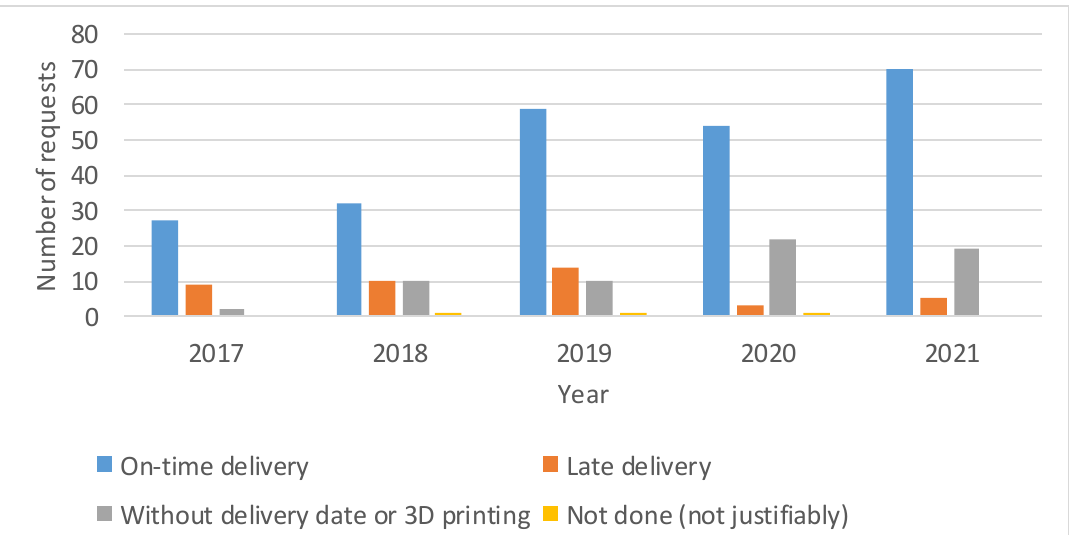
Figure 8. Evolution of the urgency of requests registered on the intranet for 3D printing models at Cruces Hospital. It shows the requests in complete years from 2017 to 2021. The 3 cases from 2016 were removed, as they are not considered representative.